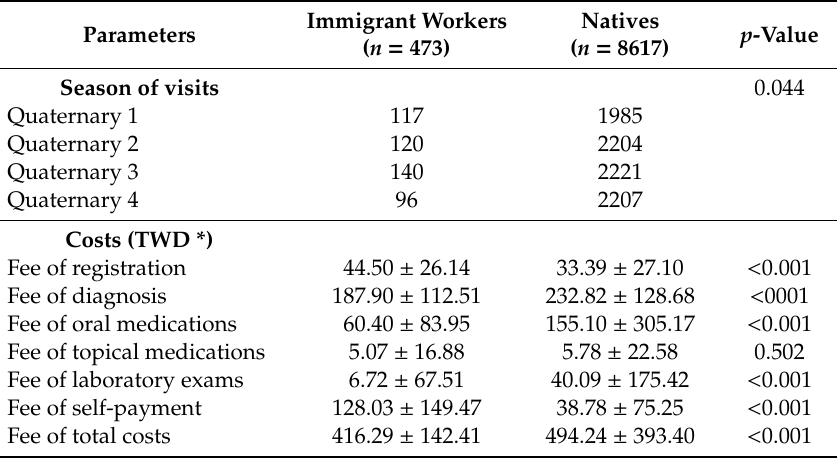
Table 2. Season of visit and cost of the subjects’ visit ( n =